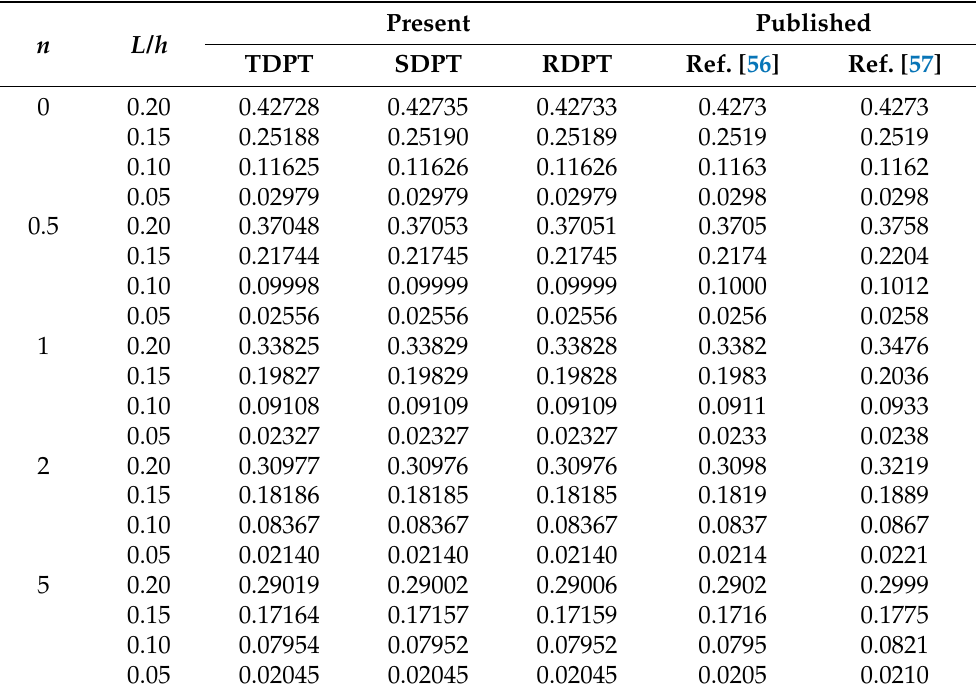
Table 3. Comparison of nondimensional frequency ˆ Ω of FG plate resting on Winkler elastic foundation ( J 1 = 100, J 2 = 0).